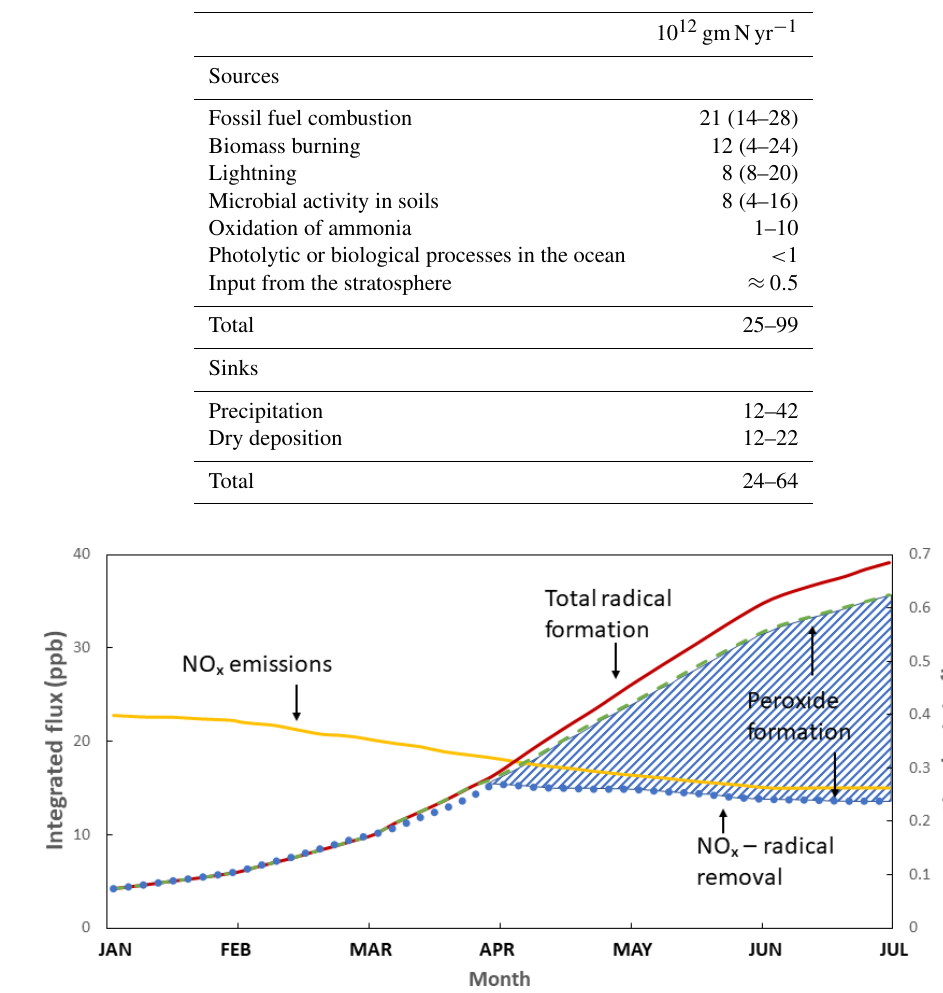
Figure 10. Calculated seasonal variation of major radical loss processes after Kleinman (1991), showing the seasonal nature of peroxide production and its dependency on NO x and radical